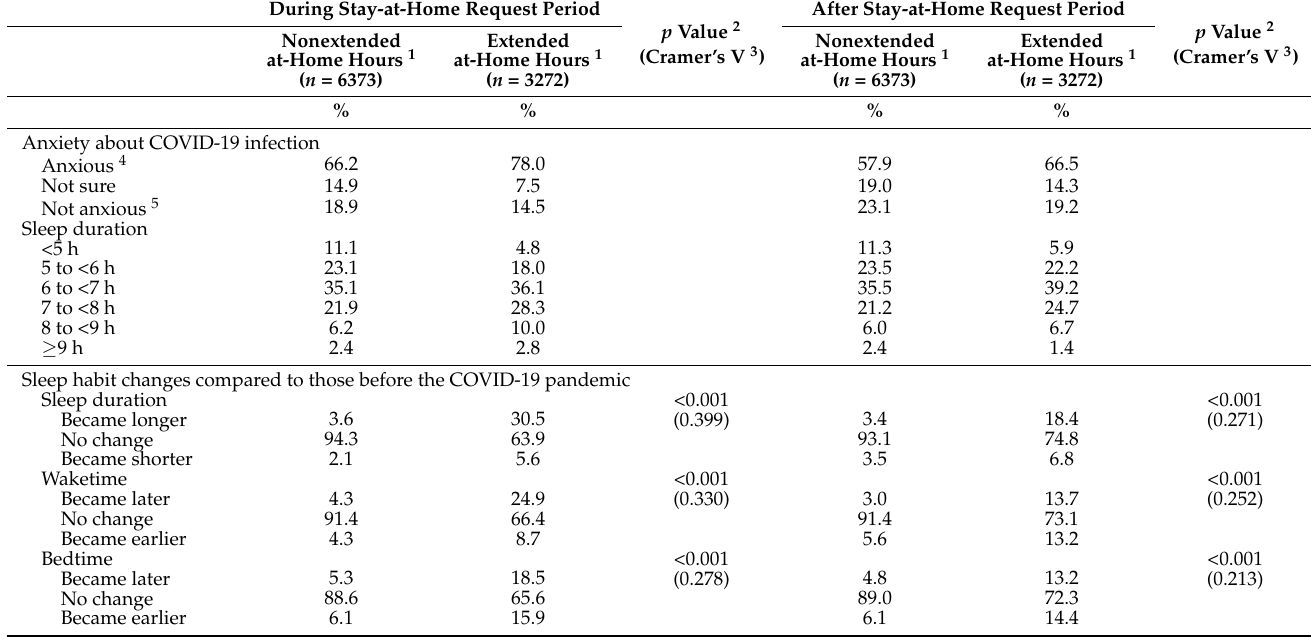
Table 3. Anxiety about COVID-19 infection and sleep habits during and after stay-at-home request period according to changes in at-home hours during the stay-at-home request